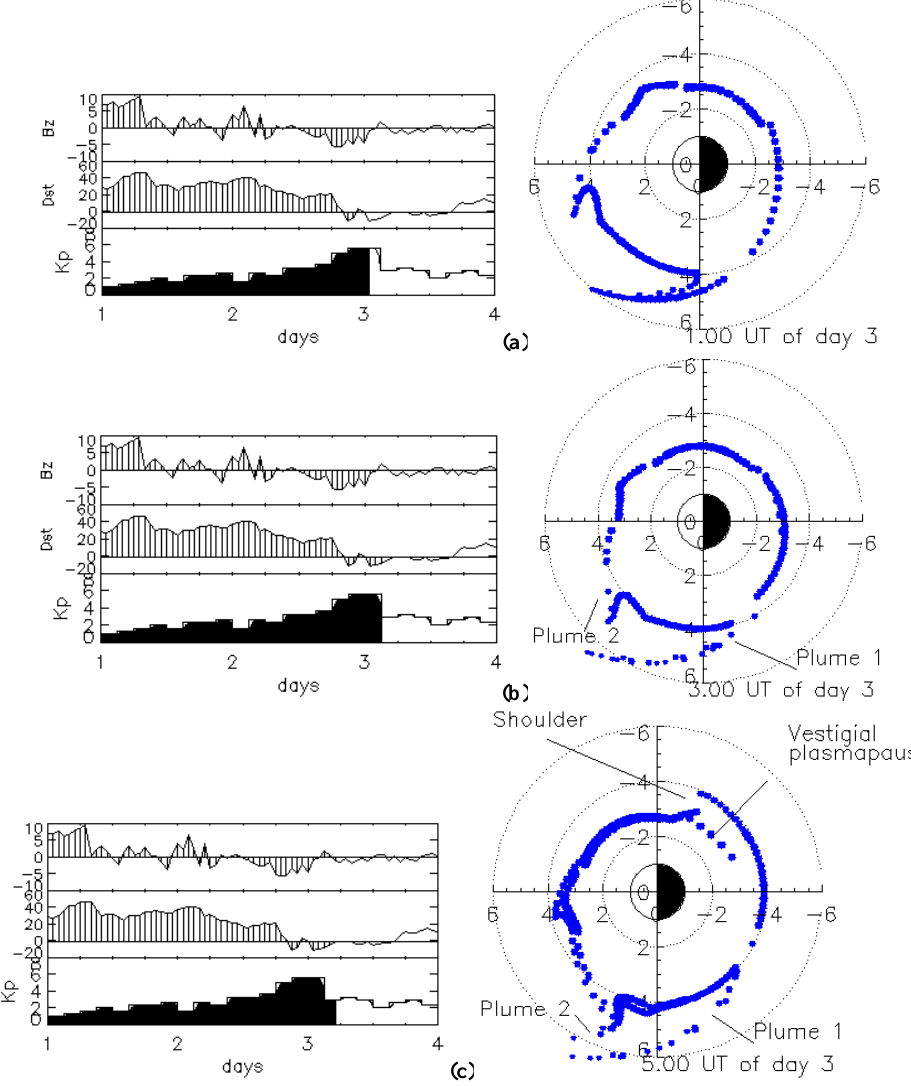
Fig. 4. Simulation of the development of plumes on 10 June 2001 at 01:00 UT (a) , 03:00 UT (b) and 05:00 UT (c) . IMAGE is too close to the Earth to provide a global view of the plasmasphere during this period of time.